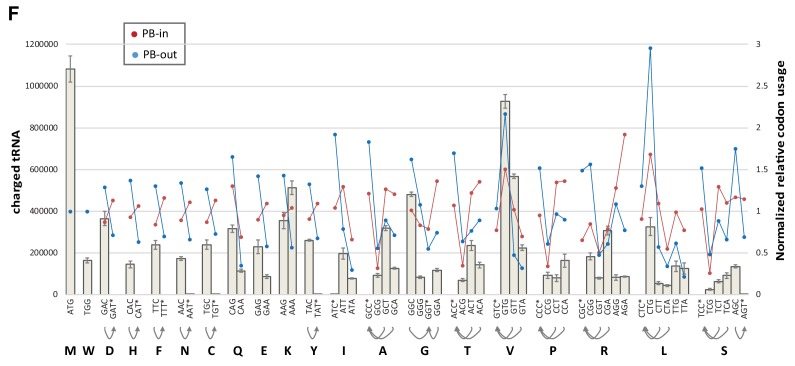
Codon usage biases and abundance of amino-acylated tRNA.Codon usage in PB-excluded mRNAs does not closely follow amino-acylated tRNA abundance. The abundance of charged tRNA isodecoders in HEK293 cells was taken from Evans et al. (24) and aggregated for each codon (gray bars). Codons with no cognate tRNA are indicated with a star, and their possible decoding by near-cognate tRNAs with arrows. Normalized codon usage in PB-enriched and PB-excluded mRNAs is on the right y axis.